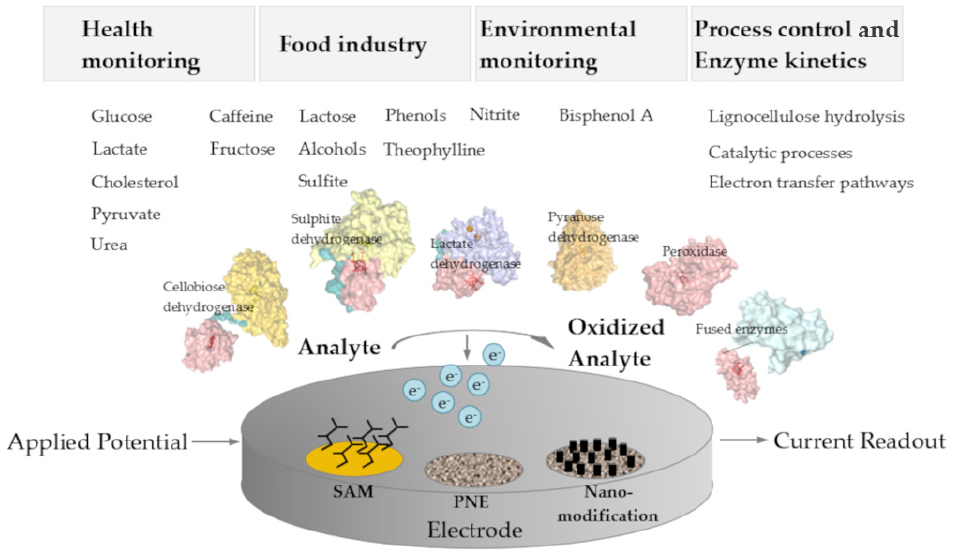
Figure 2. Schematic overview on application areas, analytes, enzymes, and the architecture of 3rd generation amperometric biosensors. SAM, self-assembled monolayer; PNE, porous nanostructured electrodes.